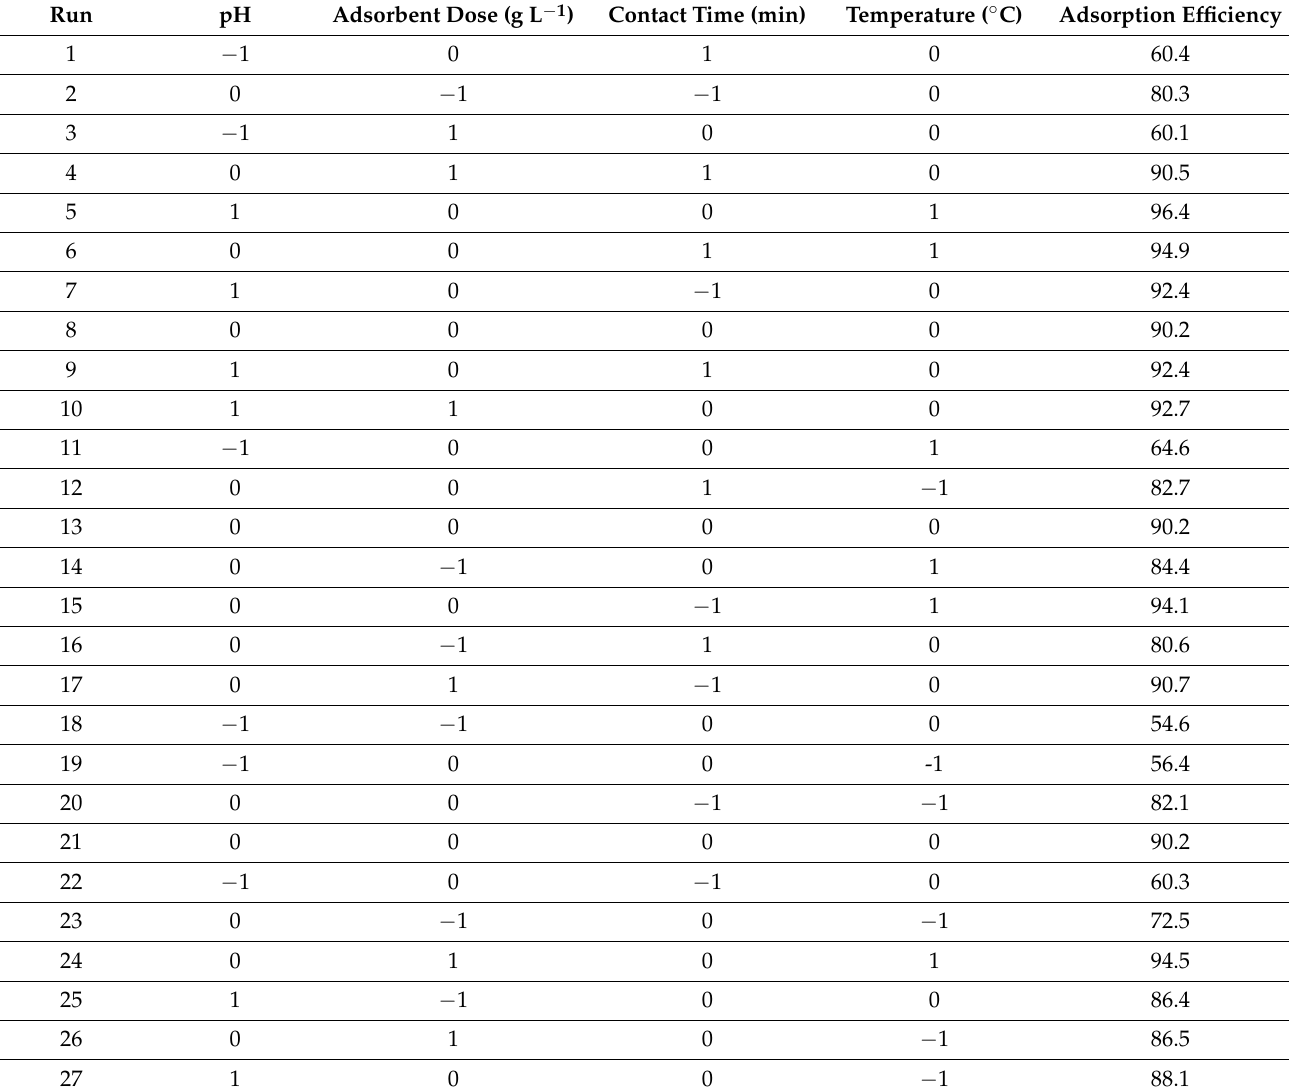
Table 4. The randomized design matrix for Box–Behnken methodology and observed responses for Pb(II) adsorption using